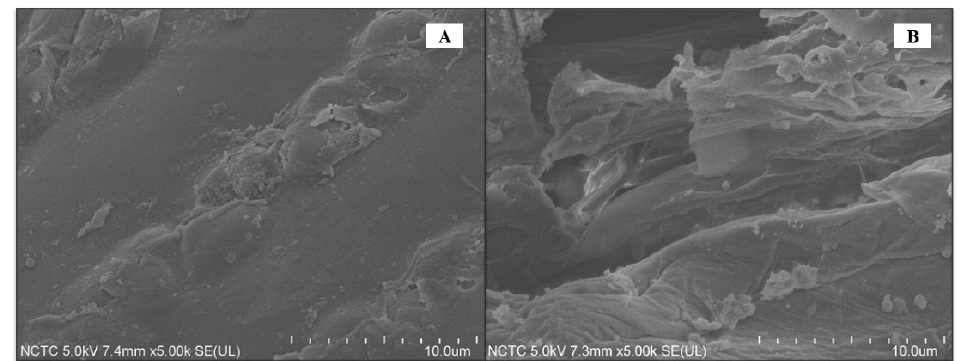
Figure 2. Scanning electron micrographs of ( A ) native sugarcane bagasse and ( B ) solid residue after pretreatment process.